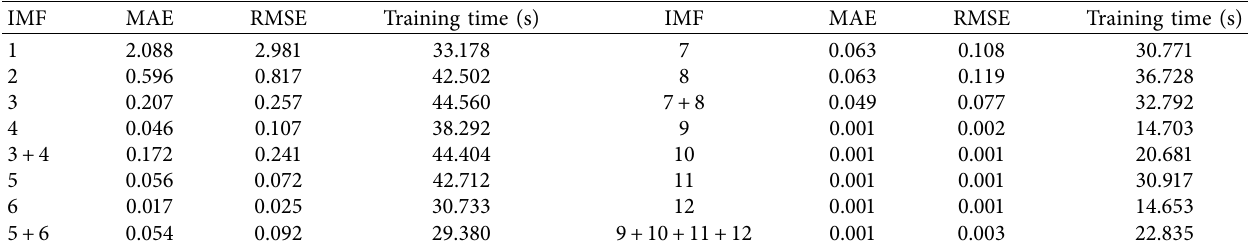
Table 5: Prediction error and training time of TCN in different IMF of